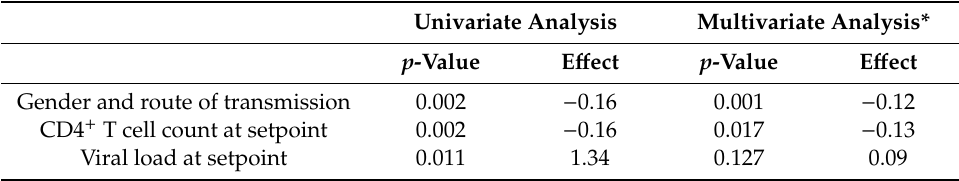
Table 2. Factors associated with the development of broadly neutralizing antibodies in participants of the Amsterdam